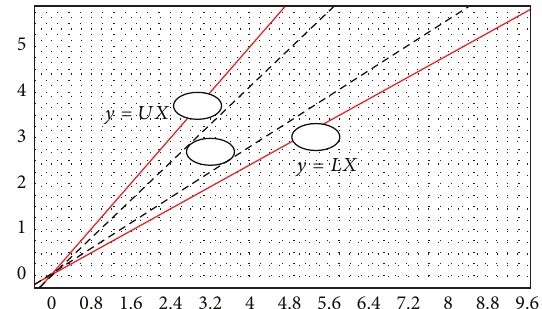
Figure 1: Bioequivalence criteria for two-parameter